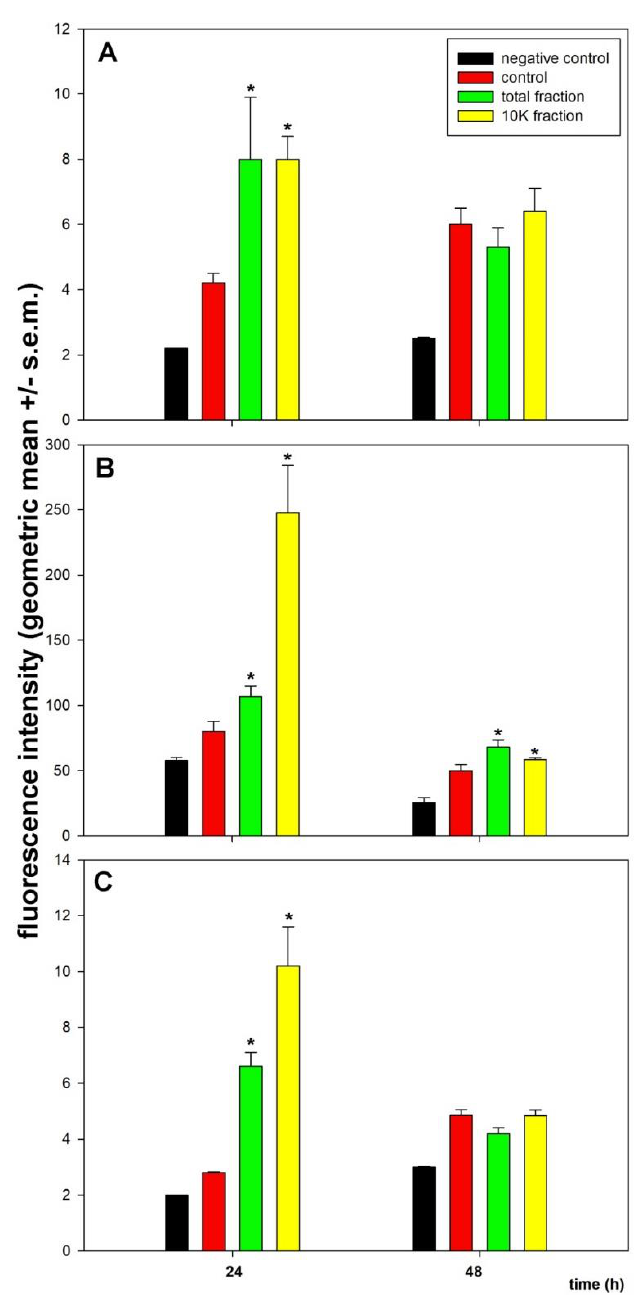
Figure 8. Histograms showing the intensity of the immunofluorescence of beclin-1 ( A ), LC3-II ( B ), and total LC3 ( C ) in control and treated MDA-MB-231 cells after 24 and 48 h of exposure. Negative controls lack the incubation with the primary antibody. Error bars correspond to the standard error of the mean (s.e.m.) of three independent measurements. * p < 0.05.